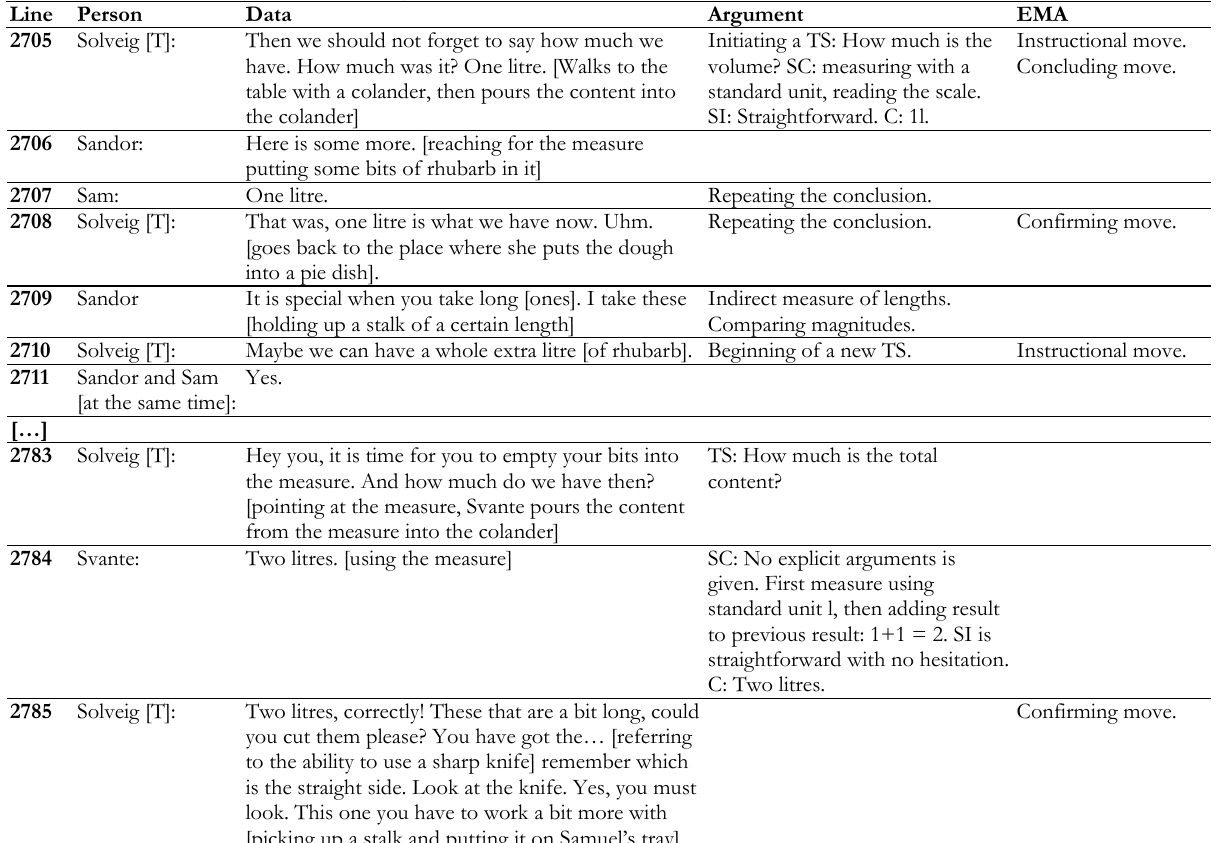
Table 1. Instructional and confirming